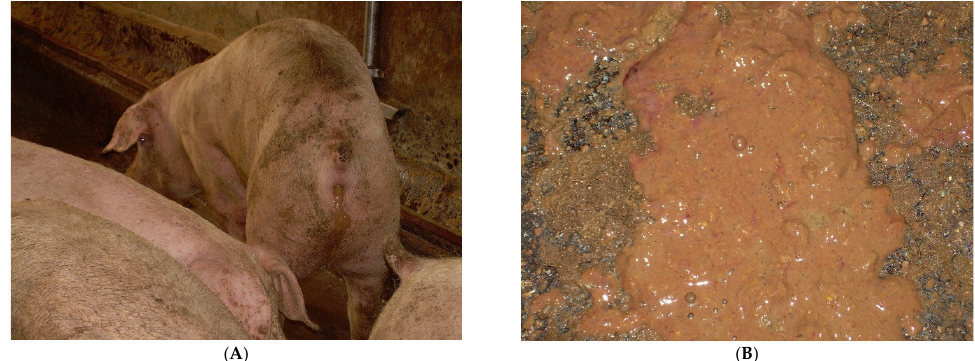
Figure 26. Pig with typical diarrhoea due to B. hyodysenteriae ( A ). Faeces are characterised by mucous, blood and muco-fibrinous exudate ( B ).